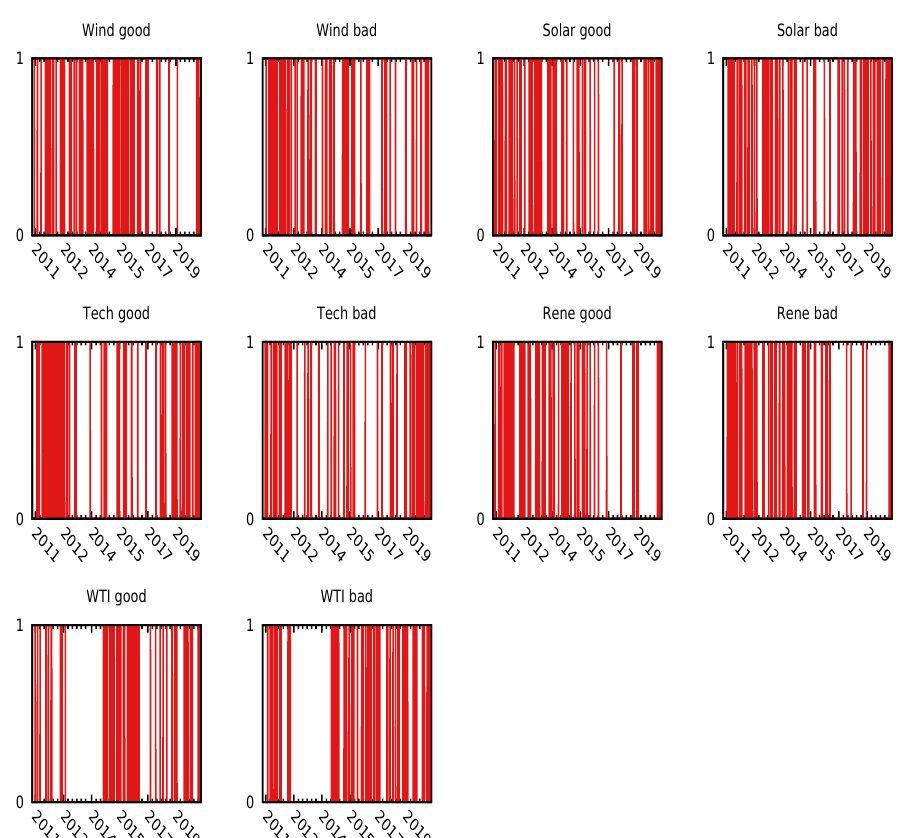
Figure 2. Daily dynamics of good and bad events. 1 indicates the day of an extreme